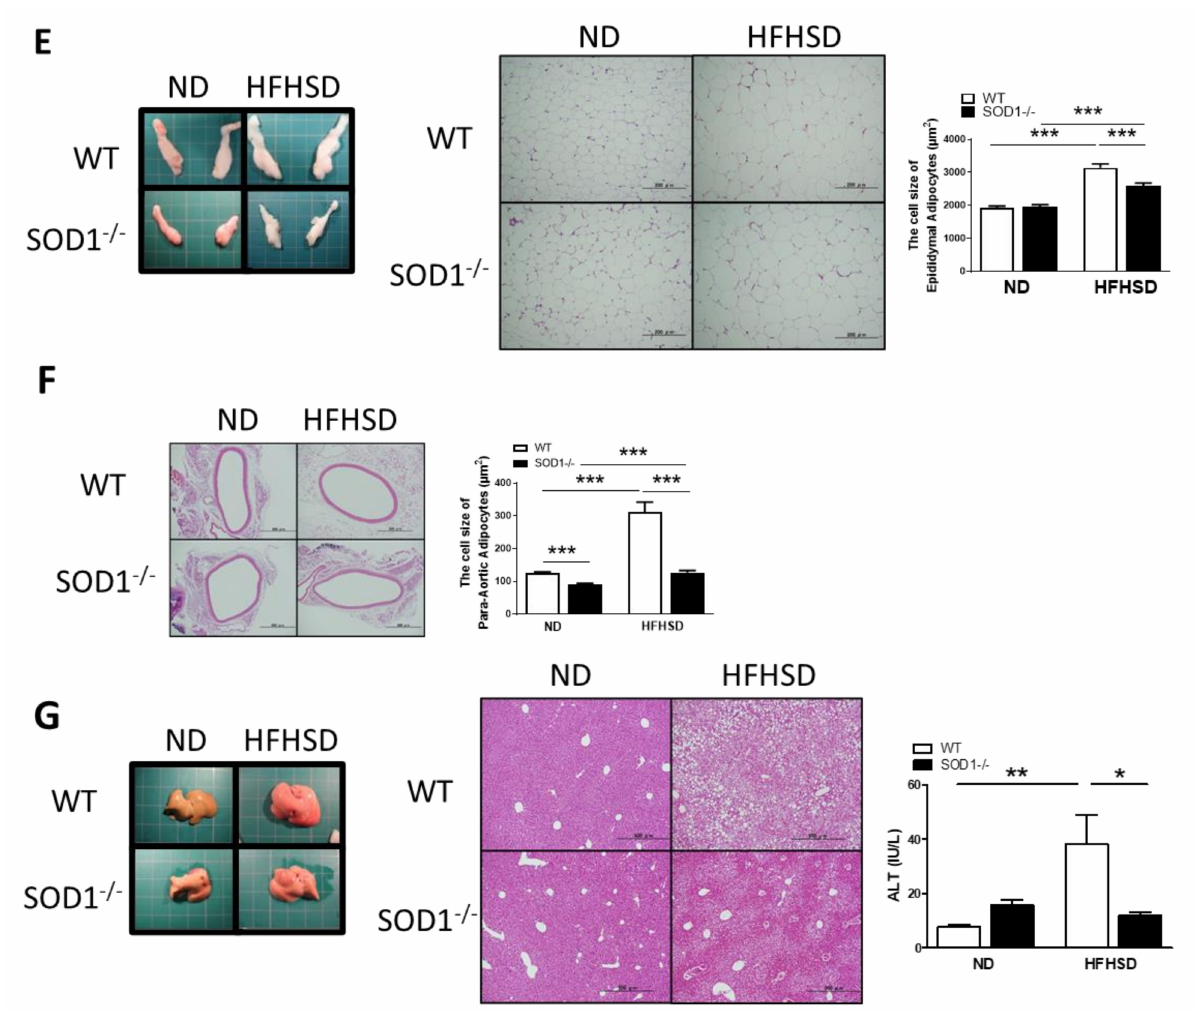
Figure 1. Study Design and Changes with ND or HFHSD. ( A ) Study design. HFHSD group fed with special diet for 24 weeks. ( B ) Western Blot Analysis of the skeletal. SOD1 deficiency was confirmed in SOD1 − / − . ( C ) DHE staining of skeletal muscle. Red fluorescence indicates O 2 · − . Scale bar is 100 µ m. ( D ) Weight curves for WT and SOD1 − / − on ND or HFHSD, respectively (WT on ND; n = 7, SOD1 − / − on ND; n = 7, WT on HFHSD; n = 6, SOD1 − / − on HFHSD; n = 9) and the picture of mice of WT and SOD1 − / − with ND or HFHSD after 24 weeks of HFHSD. The scale bar is 5 cm. ( E ) Appearance